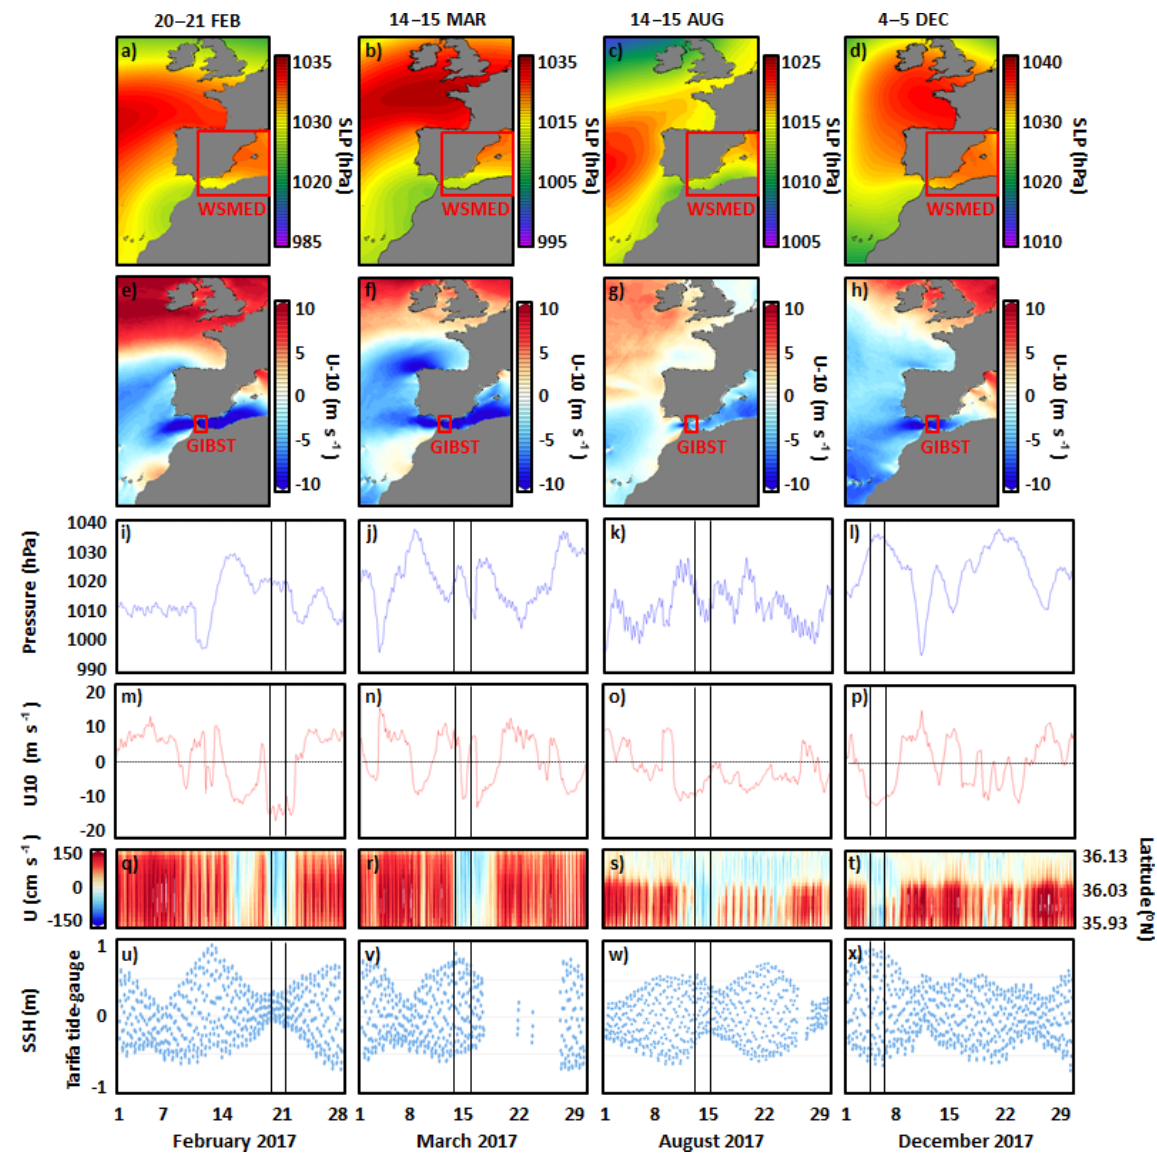
Figure 10. Two-day averaged synoptic maps of (a–d) sea level pressure (SLP) and (e–h) zonal wind at 10m height (U-10), provided by ECMWF, corresponding to each of the four Atlantic inflow reversal events analysed during 2017. (i–l) Monthly time series of SLP, spatially averaged over the Western Mediterranean Sea (WSMED) subregion, marked with a big red box in the maps of the first row; (m–p) monthly time series of U-10, spatially averaged over the Strait of Gibraltar (GIBST) subregion, marked with a small red box in the maps of the second row; (q–t) monthly Hovmöller diagrams of HFR-derived zonal current velocity at the selected transect. Red (blue) colour represent eastward (westward) flow; (u–x) monthly time series of hourly sea surface height (SSH) provided by Tarifa tide gauge, represented by a blue dot in Fig. 1. Two-day episodes of permanent flow reversal are marked with black boxes in (i–x)